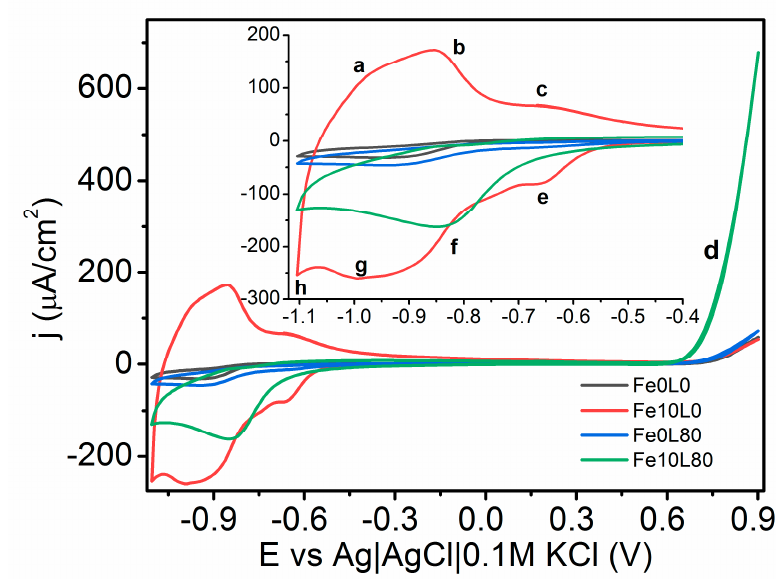
Figure 9. Cyclic voltammetry recorded for pristine and laser-modified; (80 mJ/cm 2 ) TiO 2 -NTs in 0.5 M NaOH electrolyte in